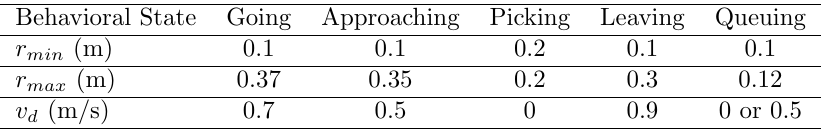
Table 1: Parameters of the CPM operational model for all the behavioral